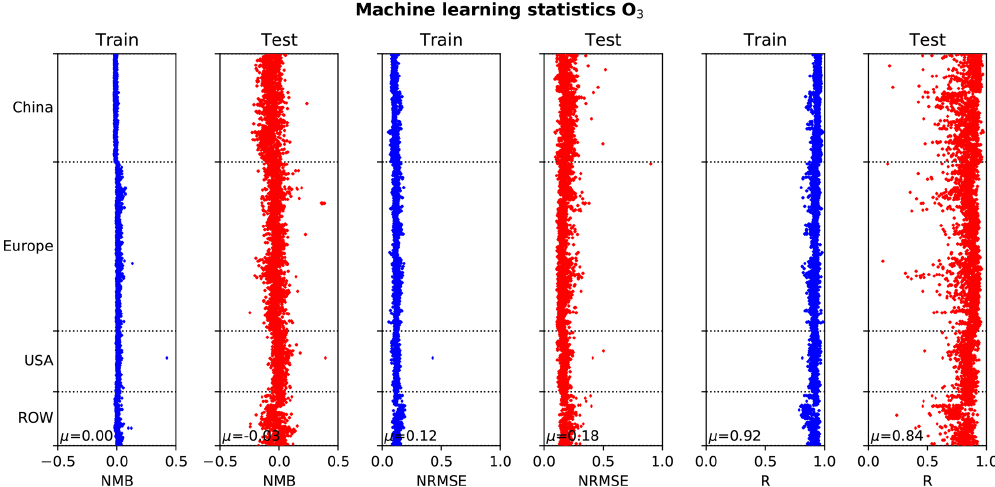
Figure 3. The same as Fig. 2 but for O 3